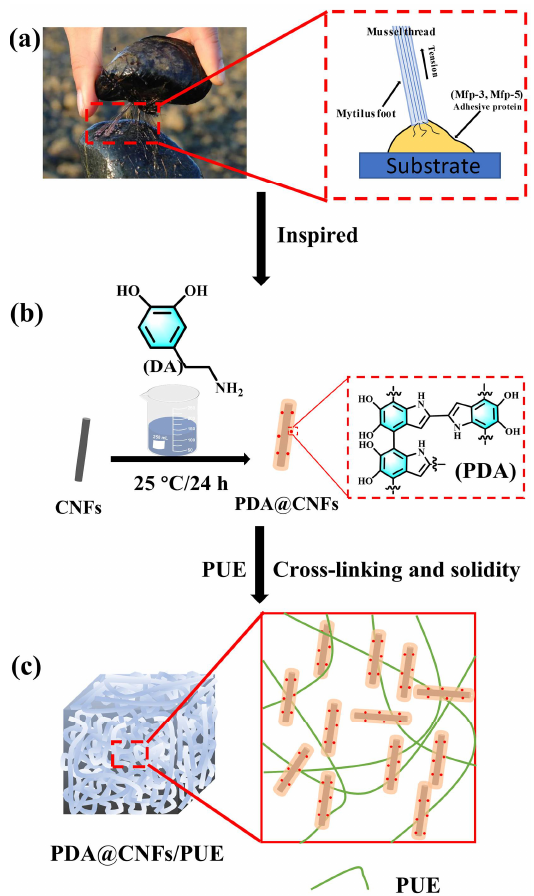
Figure 1. ( a ) Mechanism of mussel adhesion proteins, ( b ) synthesis of PDA@CNFs, ( c ) schematic diagram of PDA@CNFs/PUE covalent and non-covalent conjunction with PUEs.